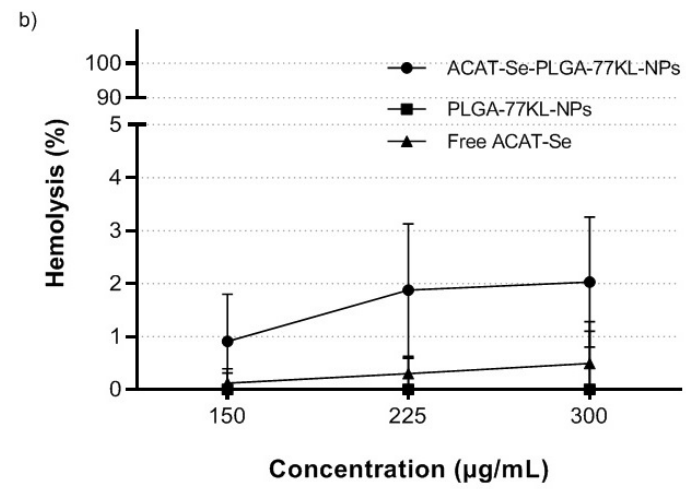
Figure 3. ( a ) In vitro cell biocompatibility of NPs evaluated using nontumor cell line 3T3 by MTT assay. MTX (50 µ g/mL) and DOX (10 µ g/mL) were also assessed for comparison purposes. Statistical